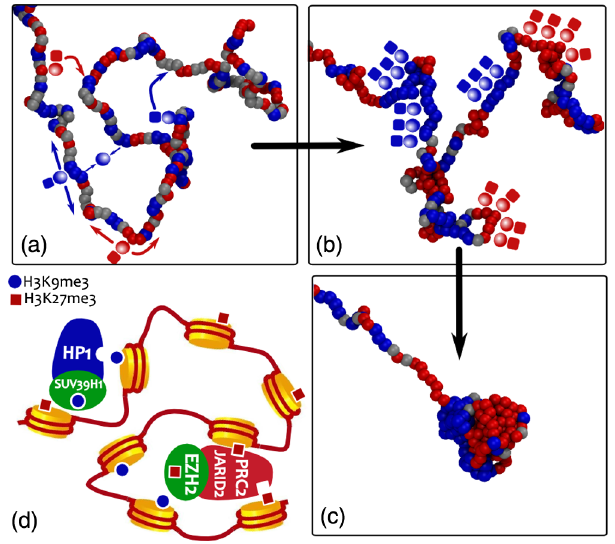
FIG. 1. A 3D polymer model with “ recoloring ” for the propagation of epigenetic marks. (a) – (c) Multivalent binding proteins, or readers (shaded spheres), bind to specific histone modifications and bridge between similarly marked segments (distinguished here via their “ color ” ). Histone-modifying enzymes, or writers (solid squares), are assumed here to be chaperoned by the bridge proteins. The writing (or recoloring) activity is a consequence of 3D contiguity (perhaps through facilitated diffusion [35]), which is modeled here as a Potts-like interaction between spatially proximate monomers [41] (a). The positive-feedback mechanism and competition between different epigenetic marks results in a regulated spreading of the mod- ifications (b), which, in turn, drives the overall folding of the polymer (c). A sketch of a biological reading-writing machinery is shown in (d). Heterochromatin binding protein HP1 is known to recruit methyltransferase proteins (e.g., SUV39H1), which, in turn, trimethylates lysine 9 on histone 3 (H3K9me3) [29,39,42]. Similarly, the Polycomb Repressive Complex (PRC2) is known to comprise the histone H3 Lys 27 (H3K27) methyltransferase enzyme EZH2 [12,39,43] while binding the same mark through the interaction with JARID2